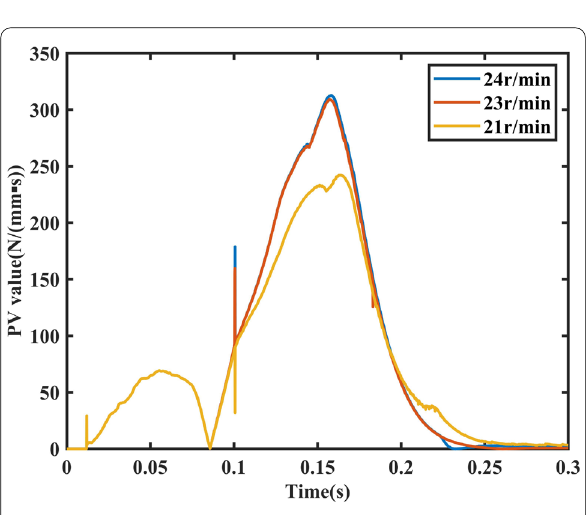
Figure 22 PV value curves of PCFRS